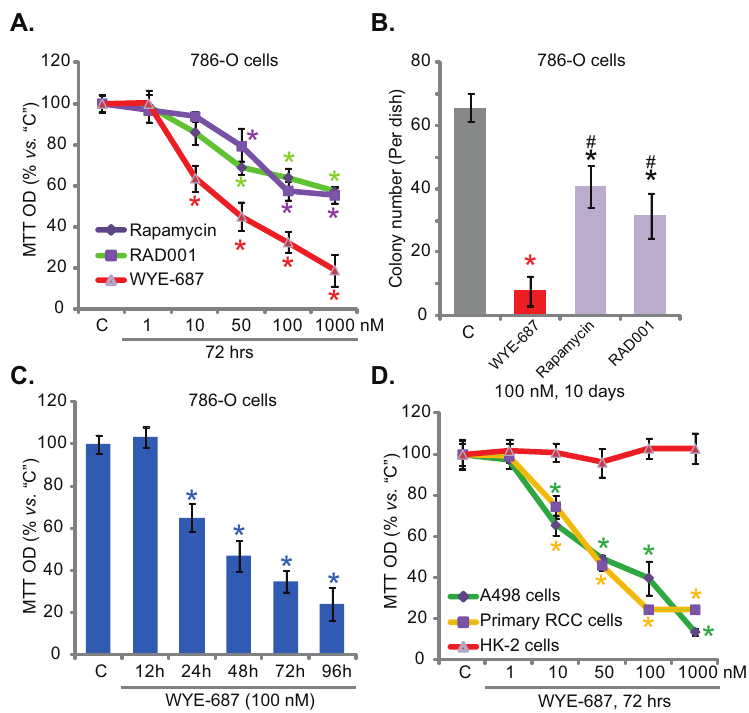
Fig 1. WYE-687 is cytotoxic to cultured human RCC cells. Established humanRCC cell lines (786-O and A498), primary human RCC cells, or HK-2 tubular epithelialcells were treated with indicatedconcentration of WYE-687, rapamycin or RAD001 for appliedtime, cell viability was tested by MTT assay (A, C and D, n = 5). 786-O cells were treated with 100 nM of WYE-687, rapamycinor RAD001for 10 days, the numbersurviving colonieswas recorded(B, n = 5). * p < 0.05 vs. untreated control group (“C”). # p < 0.05 vs. WYE-687 group (B). Vehicle control (0.1% of DMSO) failed to affect survival and proliferation of above